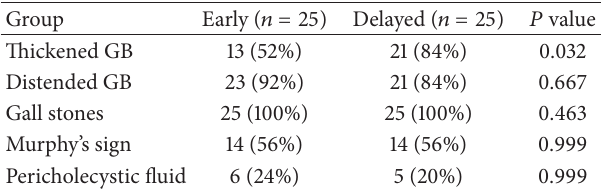
Table 1: USG findings in early and delayed